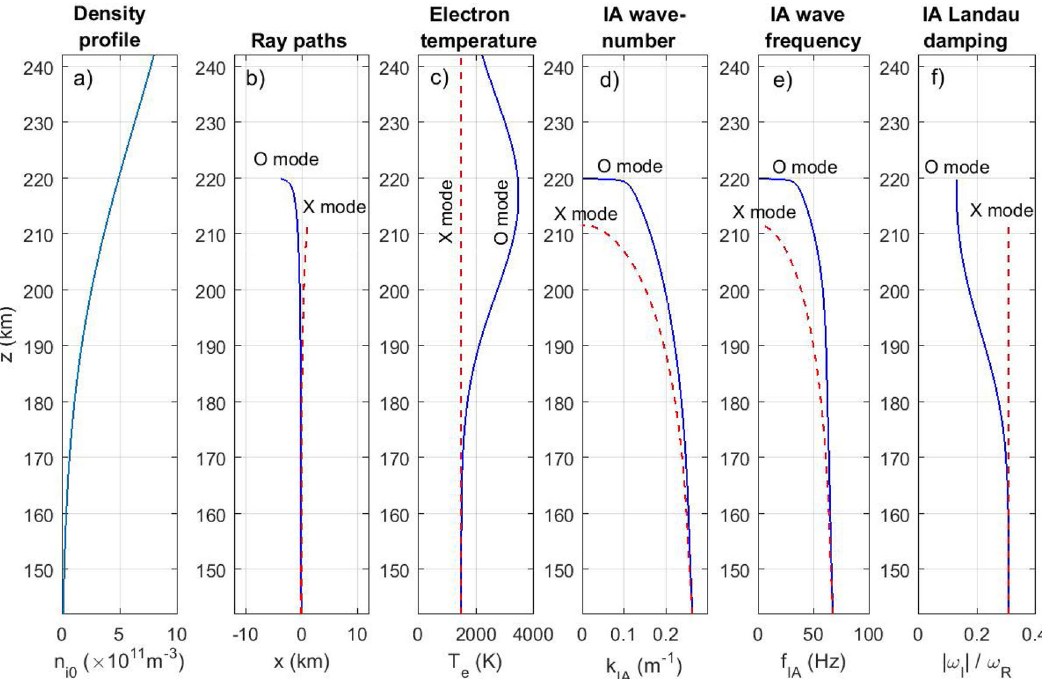
Fig. 4 Ionospheric pro fi les. a Ionospheric density pro fi le, b ray paths in the magnetic meridian ( x - z ) plane of O and X mode waves of frequency 6.3 MHz injected vertically, c the pro fi les of the estimated electron temperatures during X and O mode heating (the ion temperature is T resonant ion-acoustic (IA) wavenumber k IA ¼ 2 k EM ; z , e the resonant IA wave frequency f IA ¼ ω R = 2 π , and f the relative ion Landau damping rate ω I = ω R